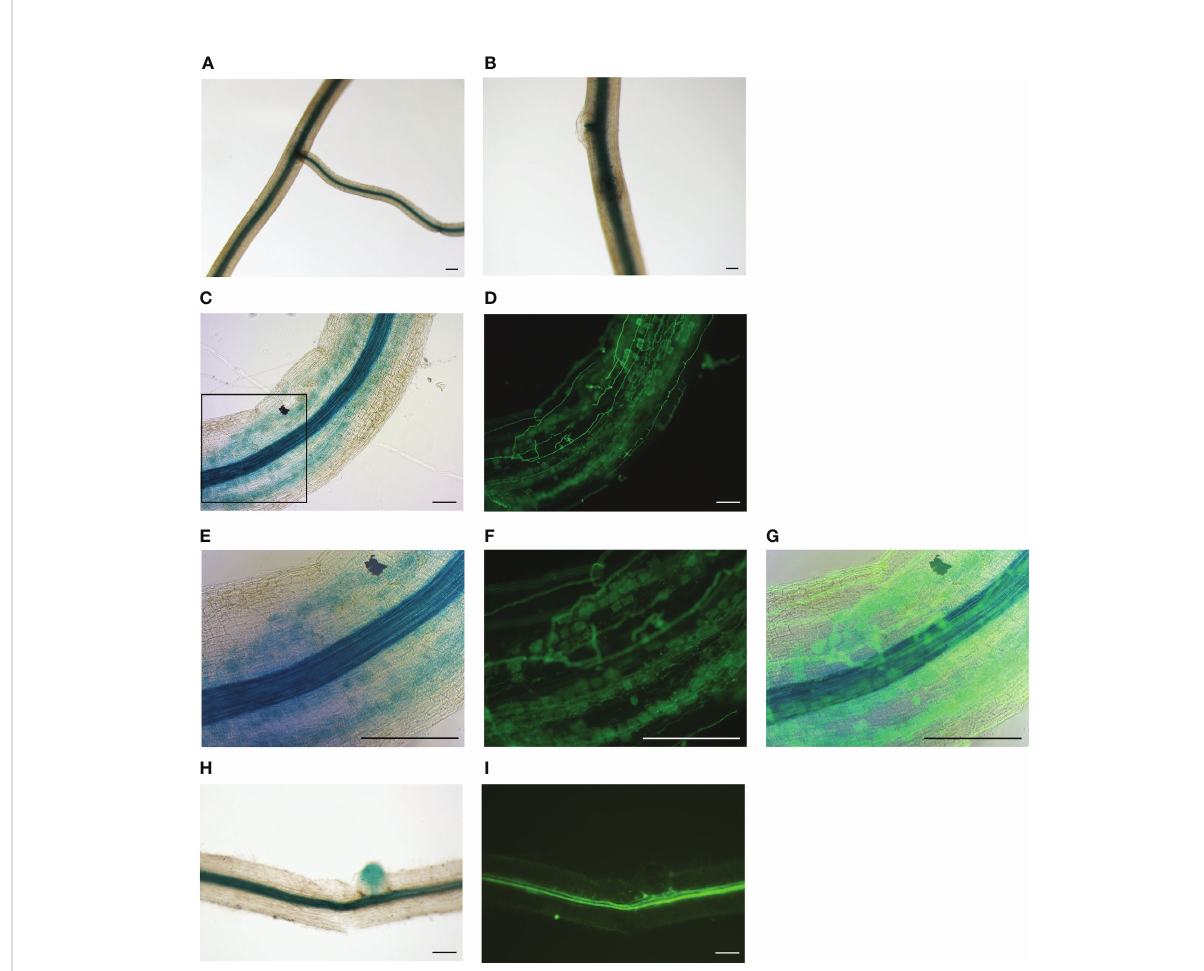
FIGURE 3 The expression pattern of MtNF-YB17 in Medicago roots. (A, B) GUS staining of roots expressing MtNF-YB17pro:GUS from mock-treated root system. (C-I) GUS staining of R. irregularis -inoculated roots expressing MtNF-YB17pro:GUS (C, E, H) . Corresponding fl uorescence images showing fungal structure stained with WGA at exactly the same region (D, F, I) . (E-G) Magni fi cation image corresponding to the black rectangle in (C) . (G) The merged image of bright fi eld and fl uorescence. (H, I) Non-colonized root fragments expressing MtNF-YB17pro:GUS from R. irregularis -treated root system. Bar = 200 m